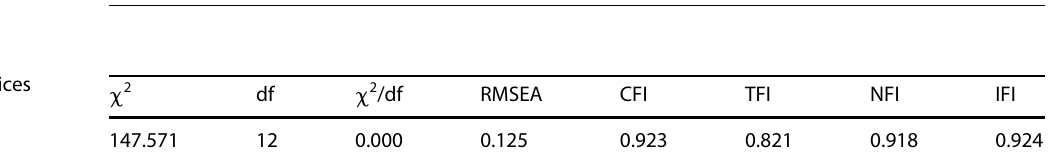
Table 3 Table of coefficients of the effect of emotional intelligence on self-efficacy